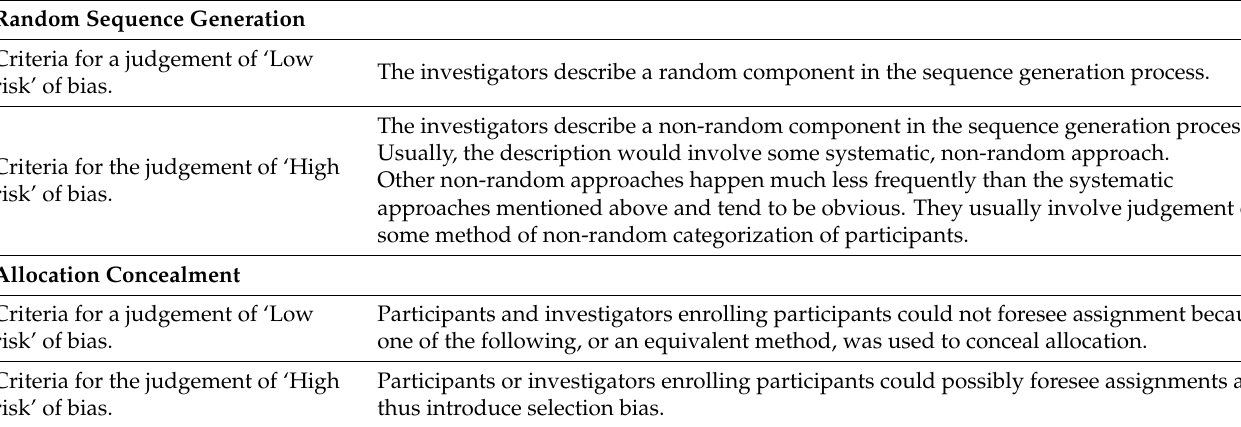
Table 1. Risk of bias of studies is represented by the green symbol, low risk of bias, and the yellow symbol, high risk of bias.